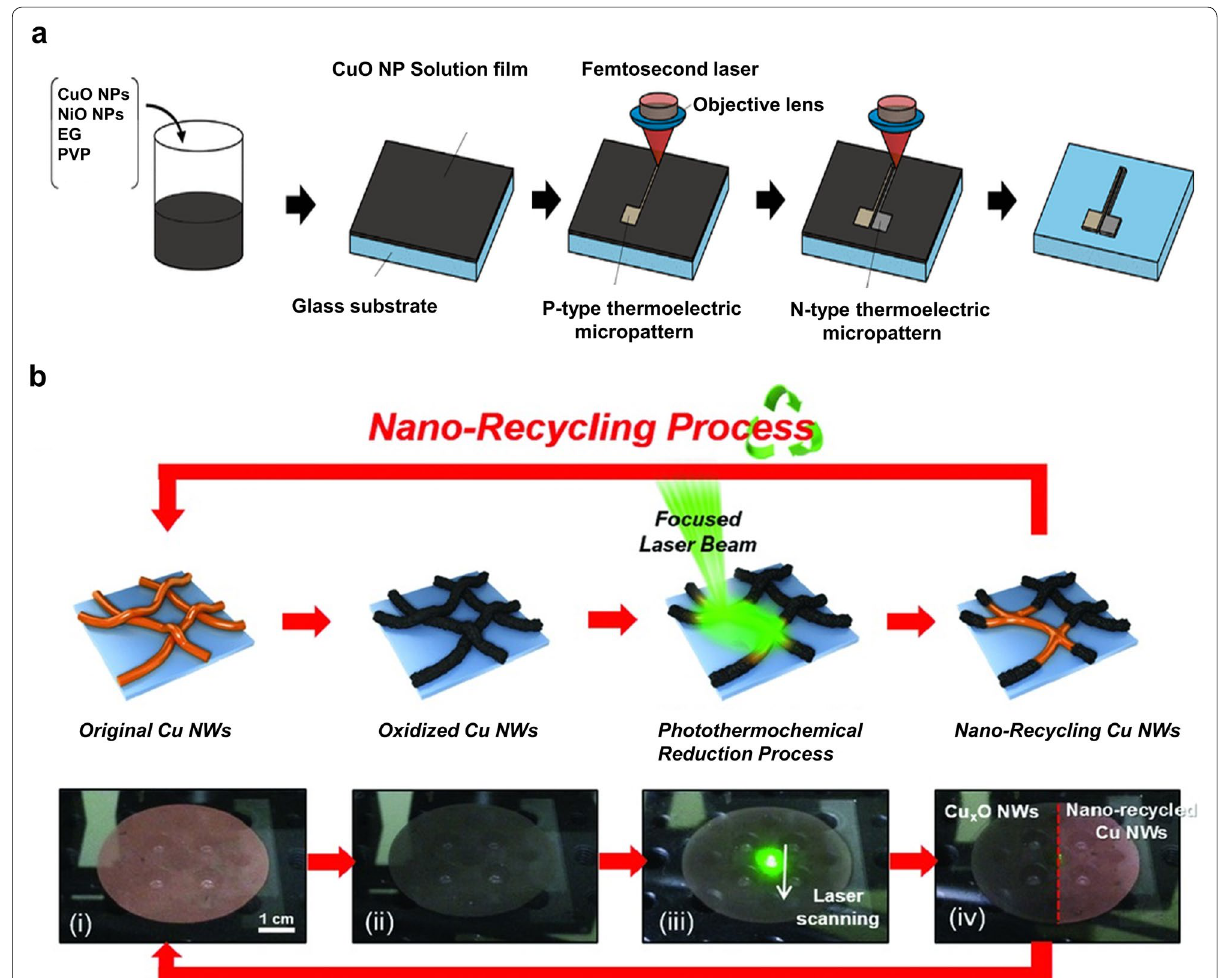
Fig. 6 a Selective fabrication of p- and n-type thermoelectric micropatterns via the reduction of CuO–NiO mixed NPs using femtosecond laser pulses. (Reproduced with permission from Ref. [83]. Copyright Springer, 2017). b Schematic of the nano-recycling process flow, with optical photographs corresponding to each stage of nano-recycling (Figures reproduced with permission from Ref. [85]. Copyright Wiley–VCH,